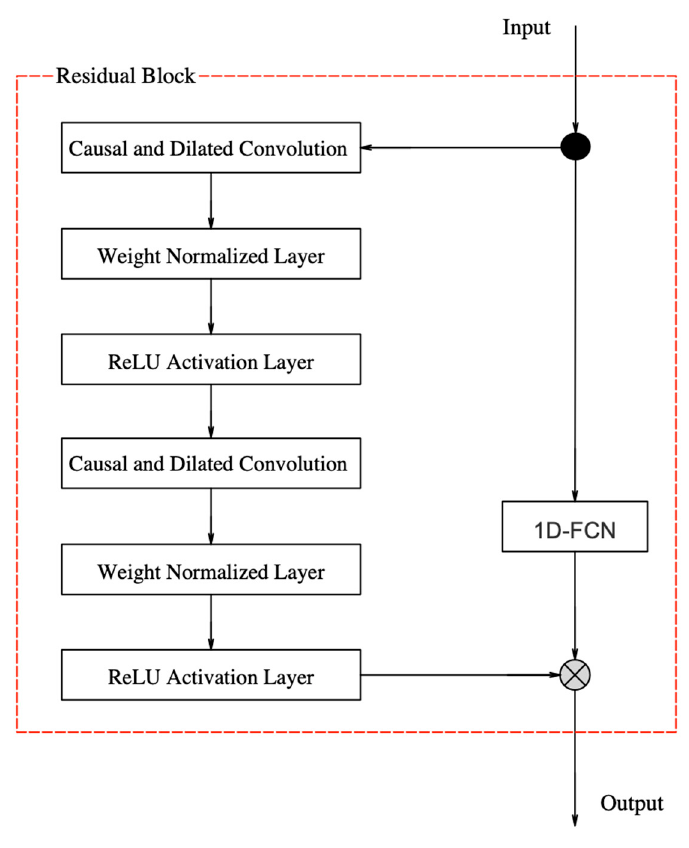
Figure 6. TCN residual block architecture.